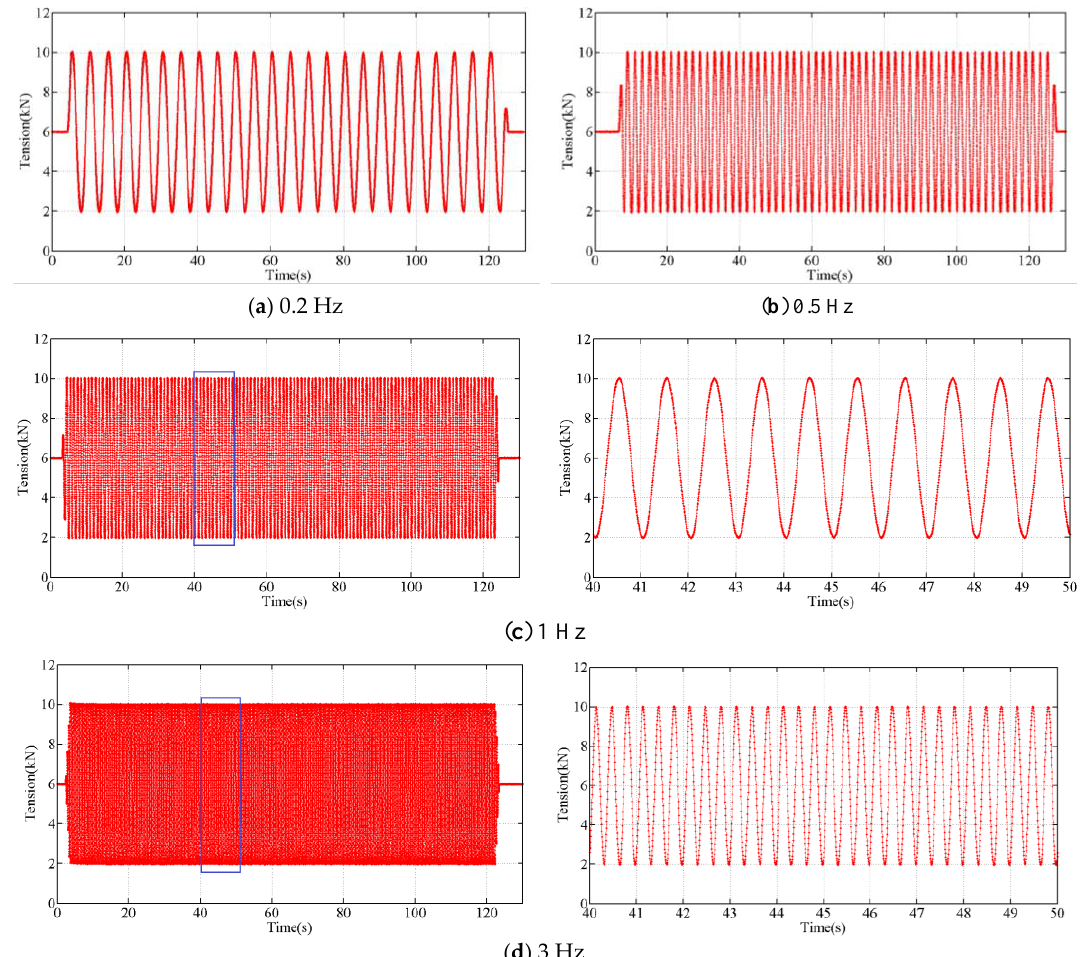
Figure 5 . The force measured during tension experiment at different frequencies.